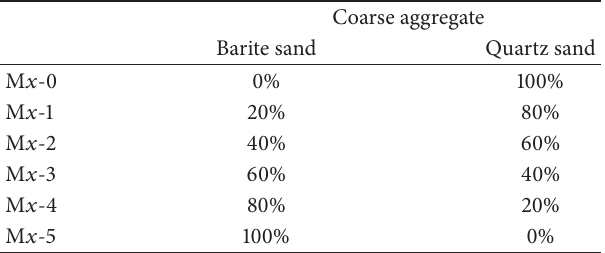
Table 3: Design mix proportions (sets).